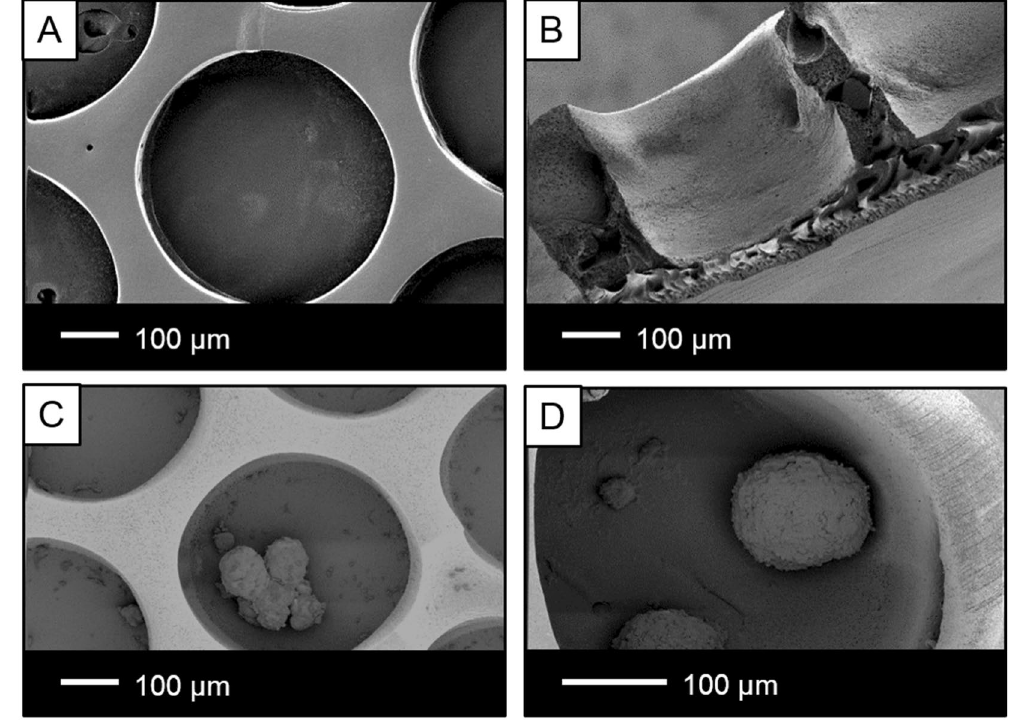
Figure 2. Scanning electron microscopy images of microwell membranes. ( A ) Top view, ( B ) Cross section, ( C ) Human islets inside the well, ( D ) MIN6 aggregates inside the